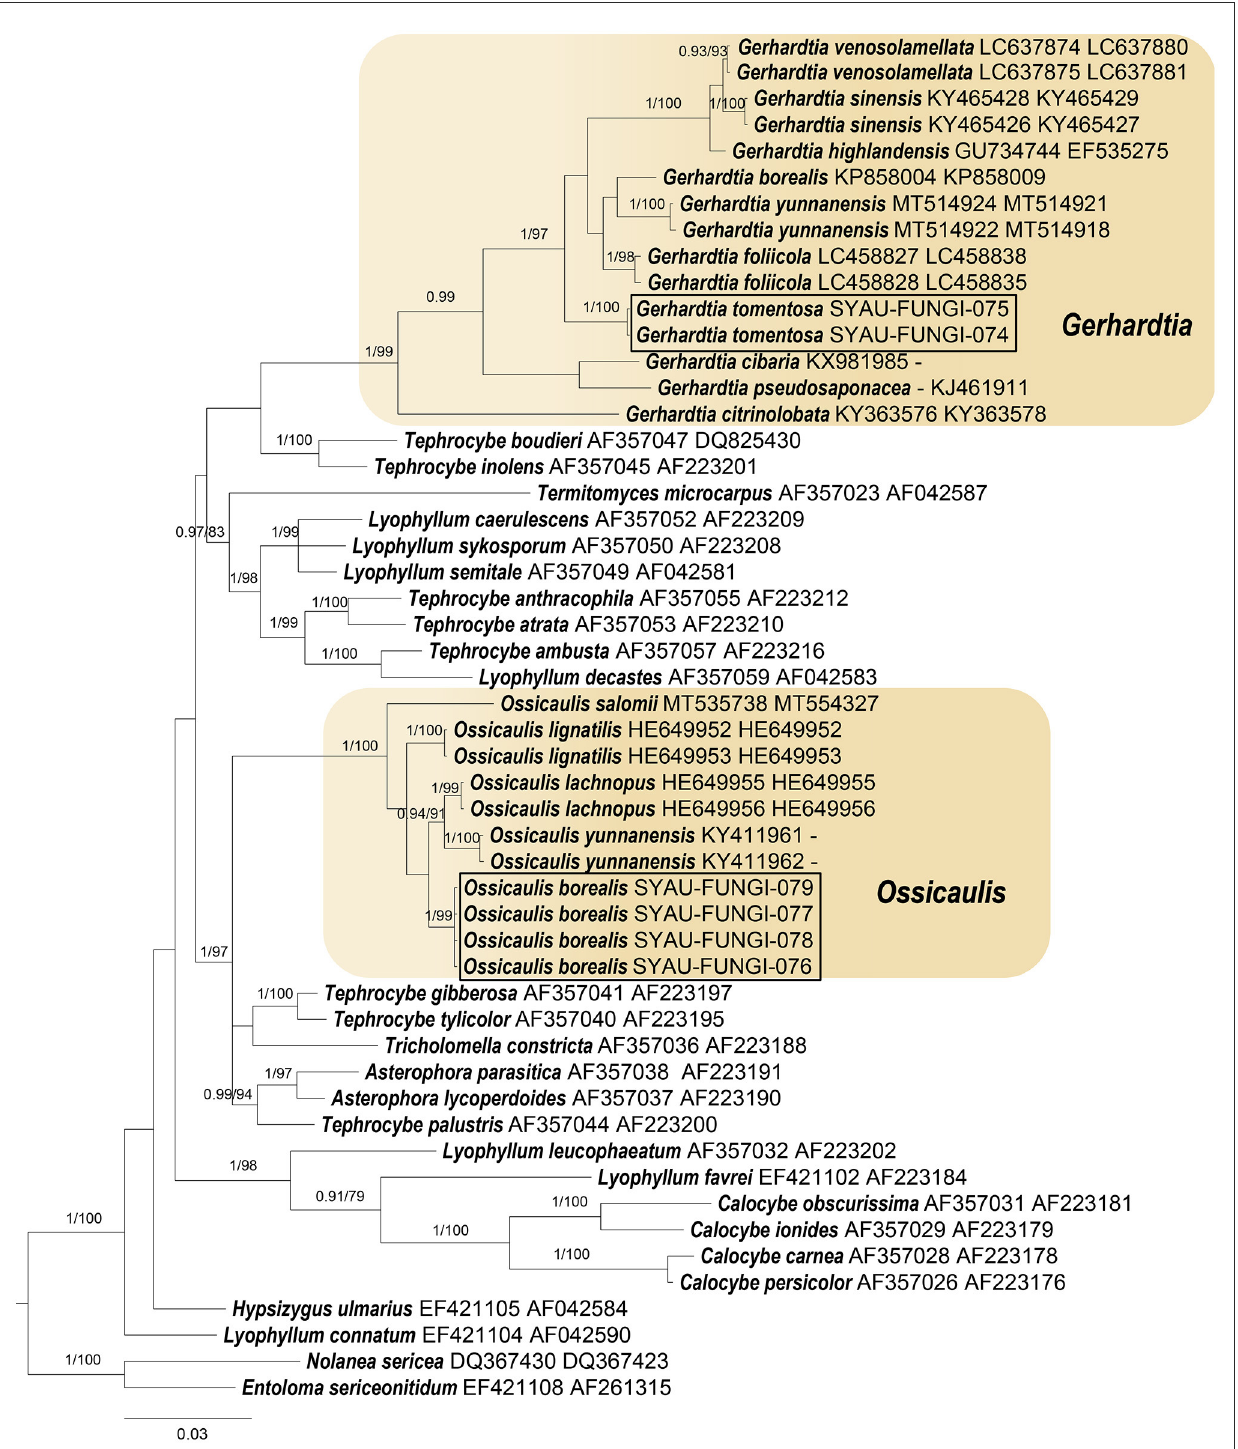
FIGURE1 ML and BI analysis of Lyophyllaceae s.l. based on ITS and nrLSU sequences. PP ≥ 0.95 (left) and BS ≥ 60 (right) are indicated on branches. Entoloma sericeonitidum and Nolanea sericea are rooted as the out-groups. Newly generated sequences for Gerhardtia tomentosa and Ossicaulis borealis are highlighted in boxes. GenBank accession numbers are provided after the species name.